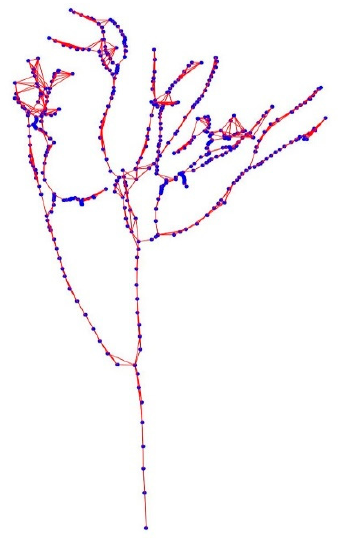
Figure 7. Graph structure for the tree.